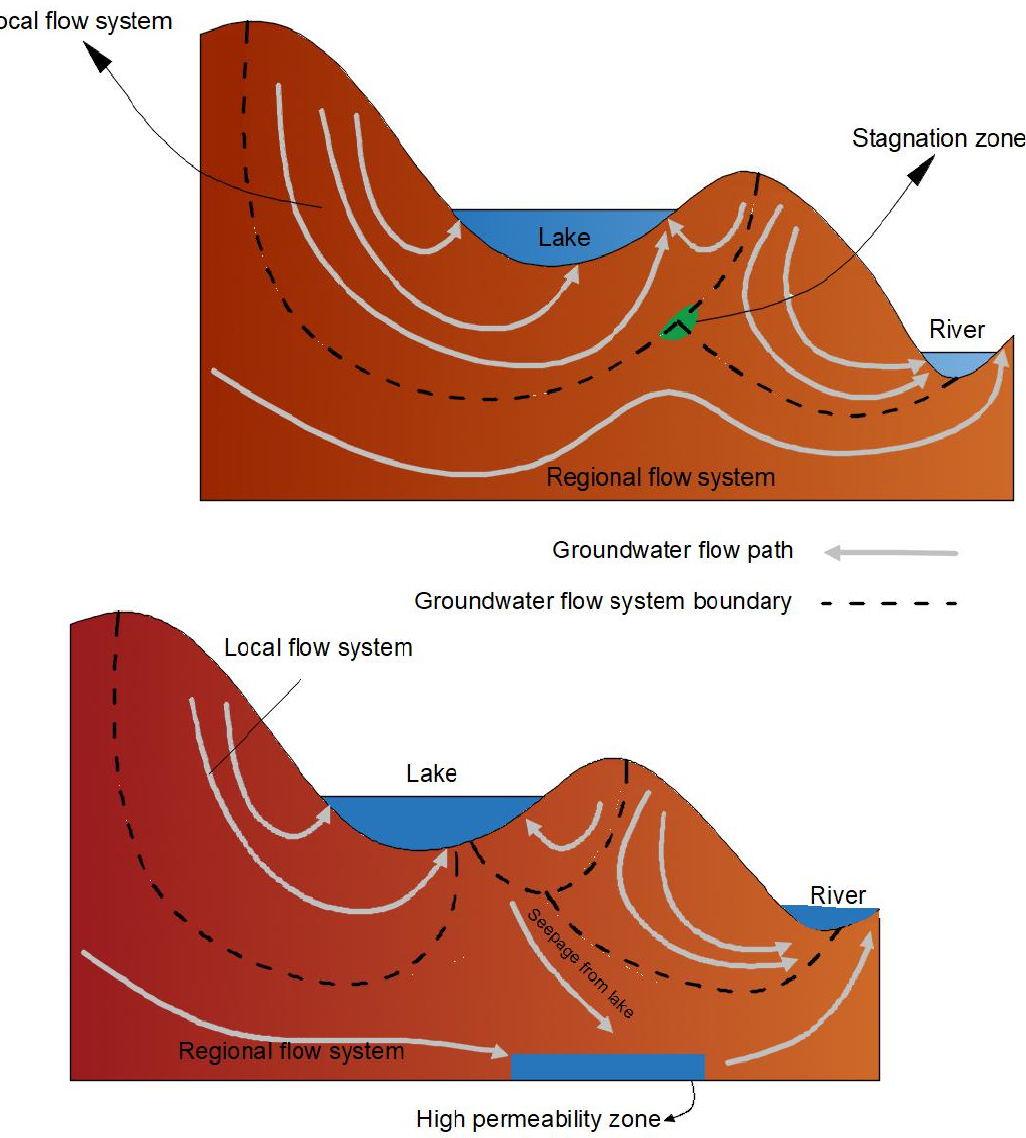
Figure 5. Conditions for seepage to occur from a surface water body with respect to groundwater flow system boundary.